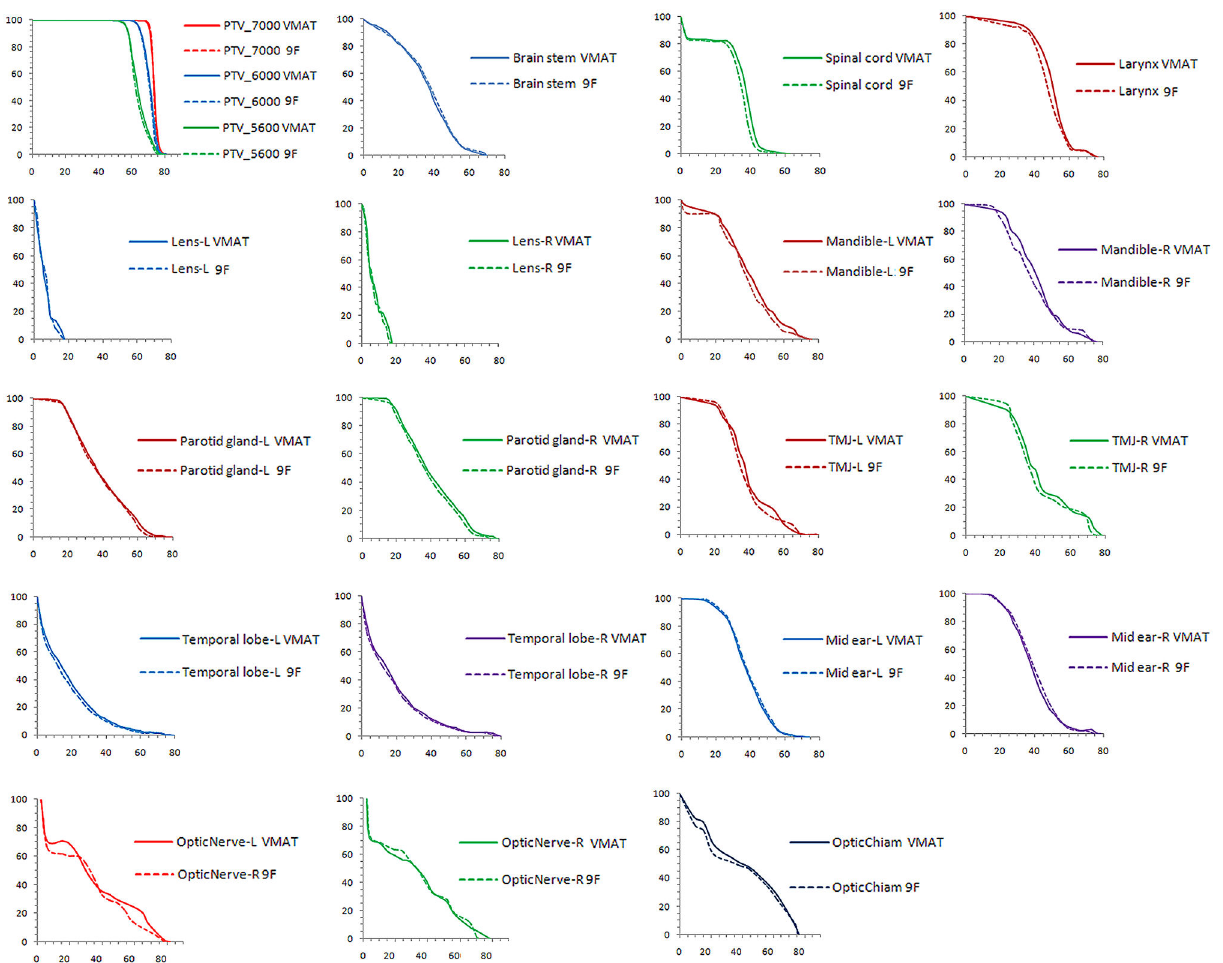
Figure 2. Average dose volume histograms for all 52 NPC patients according to the step and shoot intensity modulated radiation therapy (s-IMRT) plans and volumetric modulated arc therapy (VMAT)